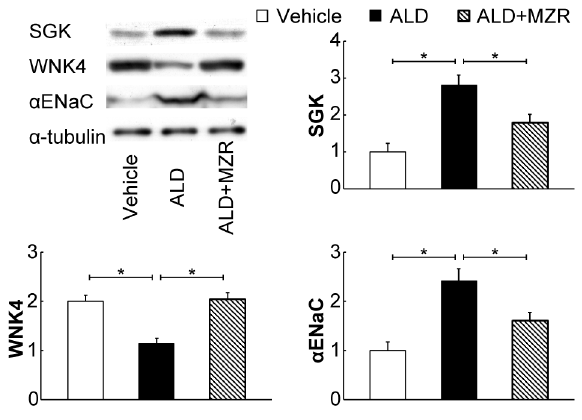
Figure 5. Mizoribine attenuates aldosterone-induced upregu- lation of serum/glucocorticoid-regulated kinase and a epithe- lial sodium channels. Western blot analysis for serum/glucocorticoid- regulated kinase (SGK), with-no-lysine 4 (WNK4), a epithelial sodium channel ( a ENaC), and a -tubulin was performed. The total cell lysate was prepared from the renal cortex of rats. Aldosterone (ALD) increased the expression of SGK and a ENaC, and decreased the expression of WNK4, whereas mizoribine (MZR) attenuated these alterations. Graphs show the expression level quantified by densitometry and normalized with a - tubulin. Values are presented as mean 6 SEM. * P , 0.05.